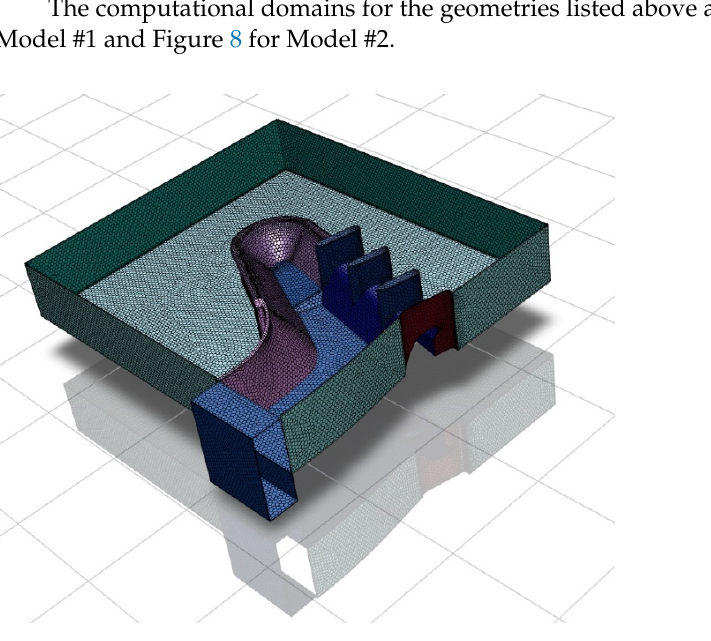
Figure 7. Computational domain for Model #1.